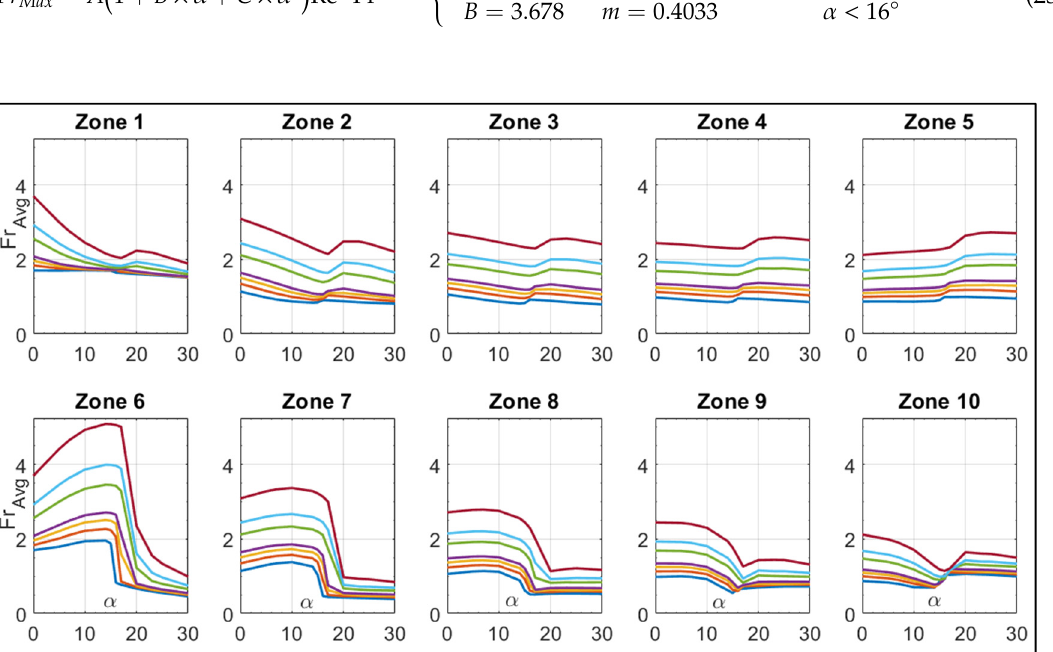
Figure 7. Fr variation for 10 considered airfoil zones.